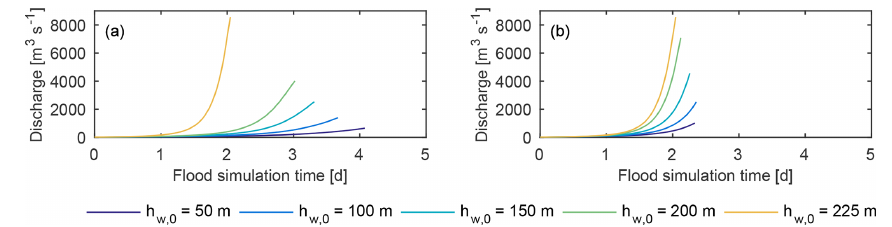
Figure 6. Demonstration of the impact of floating ice on outburst flood hydrographs for an ice dam height of 250m (year 50 in the glacier simulations). The glacier geometry and basin shape (box) are the same in all simulations. In panel (a) , the initial water height, h w , 0 , is varied and there is no floating ice in the basin. The initial water heights are the same in panel (b) except that enough floating ice is added to force ice dam flotation. For h w , 0 = 225m, the water level is equal to flotation depth so there is no remnant ice, and the curves in panels (a) and (b) are the same. Note that the modeled hydrographs do not include the rapidly falling limb of the floods because the outburst flood model is not capable of handling open channel flow, which occurs when the basin water level drops below the conduit roof.